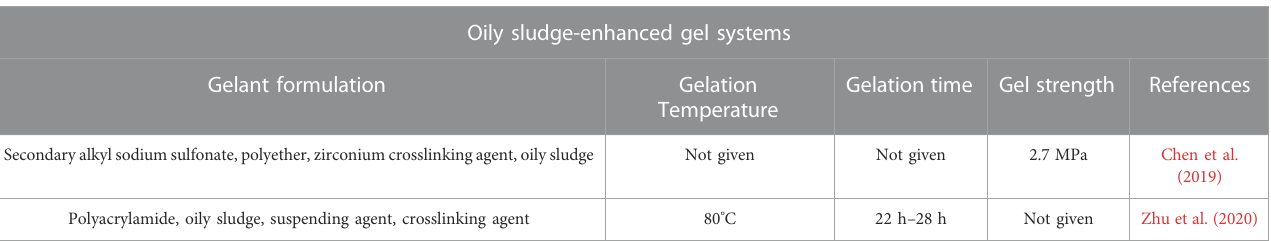
TABLE 4 Progress of oily sludge enhanced gel